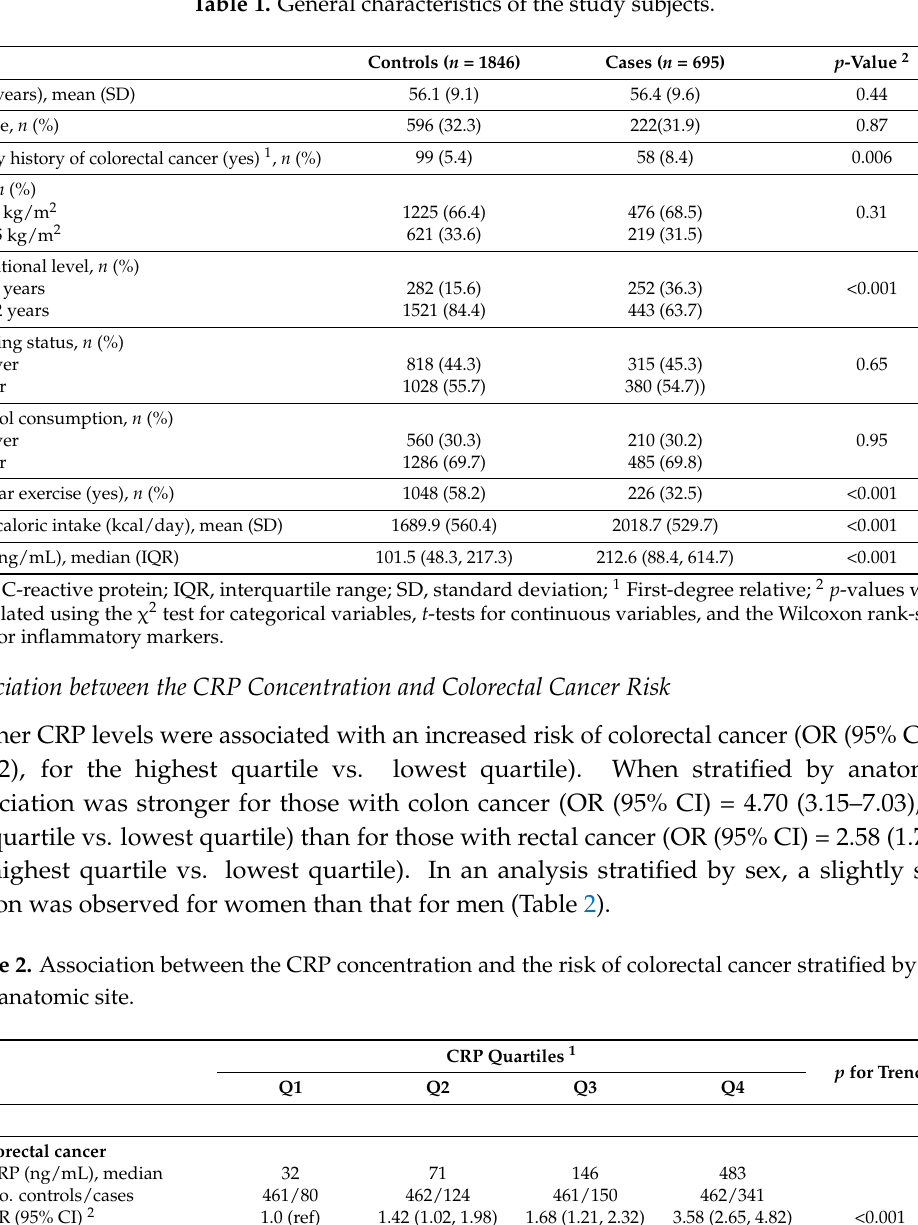
Table 1. General characteristics of the study subjects.